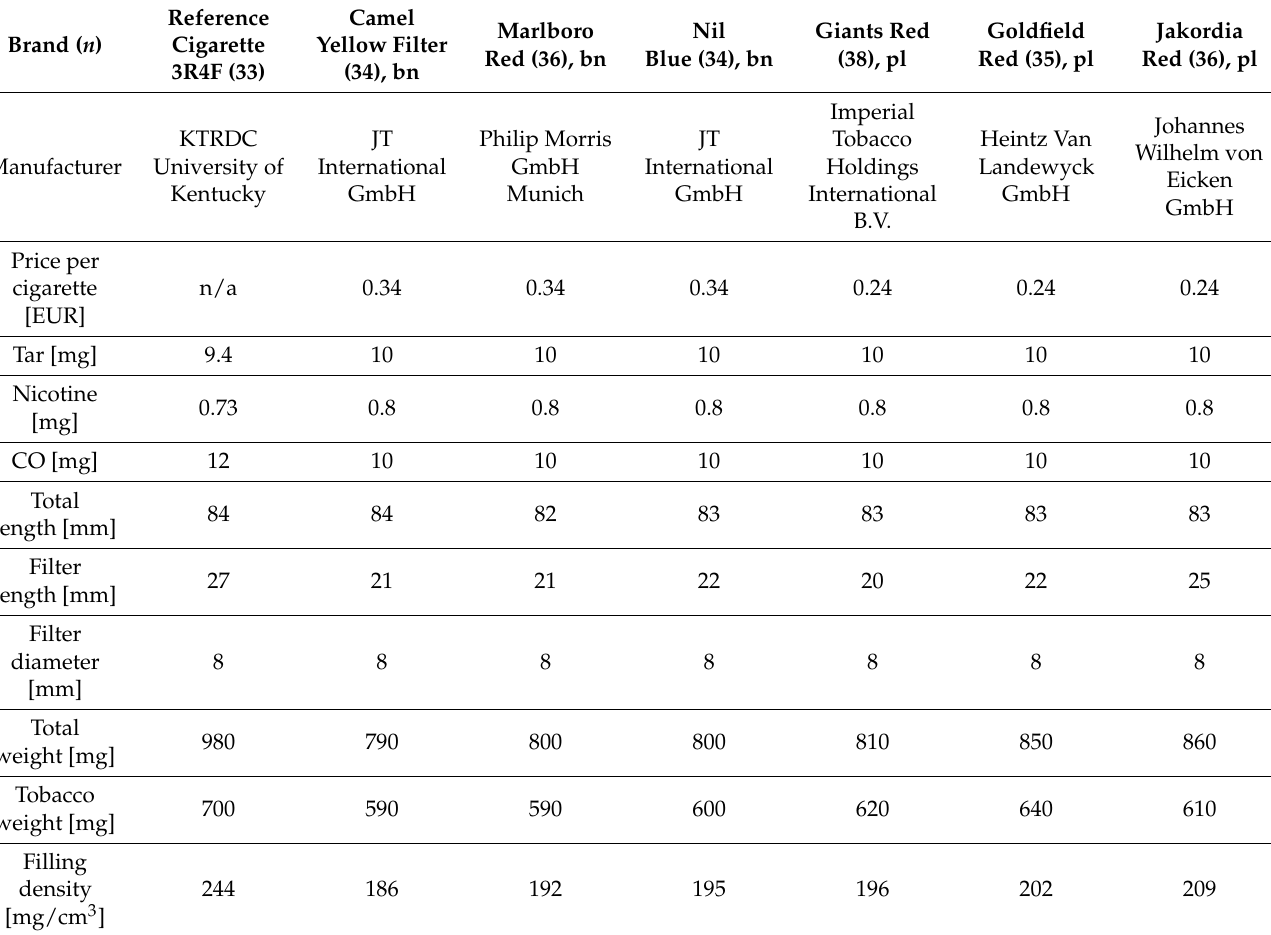
Table 1. Characteristics of the investigated tobacco products. Dimensions and weights are the mean values of five randomized chosen tobacco products of each brand. Amounts of nicotine, tar, and carbon monoxide (CO), as stated by the manufacturers. The number of cigarettes investigated ( n ) after testing for outliers (Grubb’s test) is given in brackets. bn = brand-name cigarette. pl = private-label cigarette. KTRDC = Kentucky Tobacco Research & Development Center. n/a = not